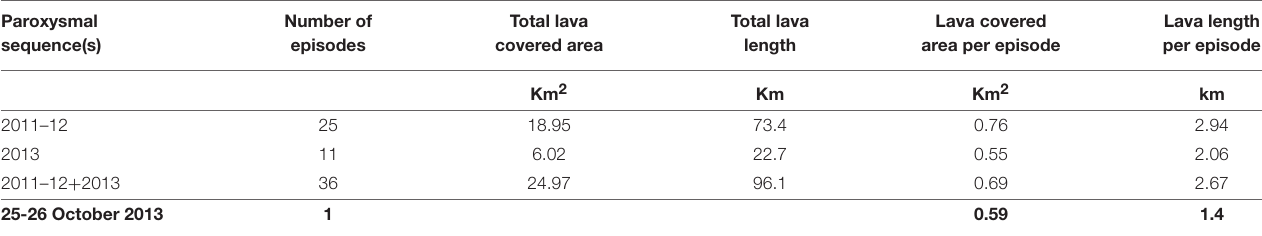
TABLE 3 | Volcanological parameters of the NSEC cone during the 2011–12 and 2013 lava fountaining sequences, and the single 25-26 October 2013 paroxysm. Paroxysmal sequence(s)